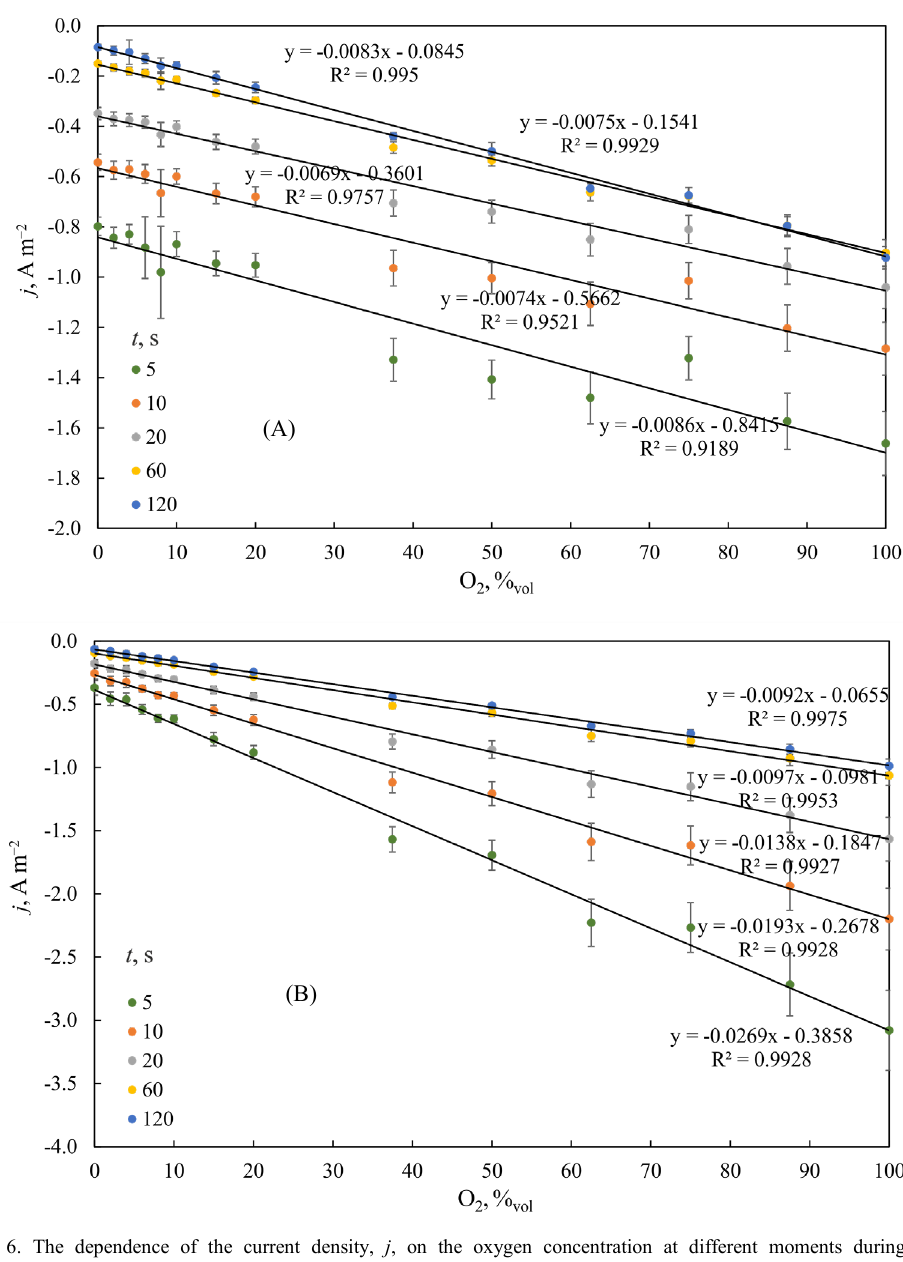
Fig. 6. The dependence of the current density, j , on the oxygen concentration at different moments during the chronoamperometry experiment in the 0.1 M KCl solution saturated with mixture of nitrogen and oxygen ( p tot = 101 kPa) at different partial pressures of oxygen. The pumping speed of the solution was 2 cm 3 min −1 . (A) Before and (B) after cyclic voltammetry measurement. As the cyclic voltammogramms showed good stationary behaviour, CA measurements were also performed at potential E = −0.3 V, which is close to peak potential. The CA curves